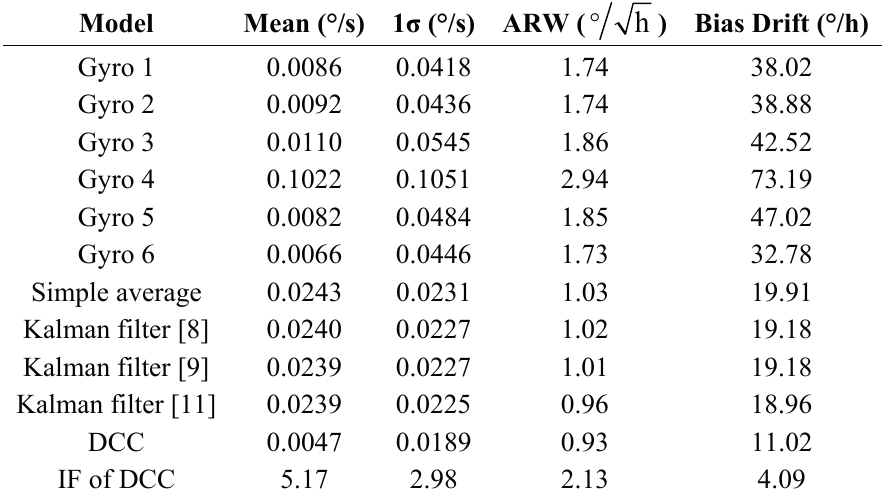
Figure 9. Allan variance results of the virtual gyro compared to the single gyro. Table 3. Experiments